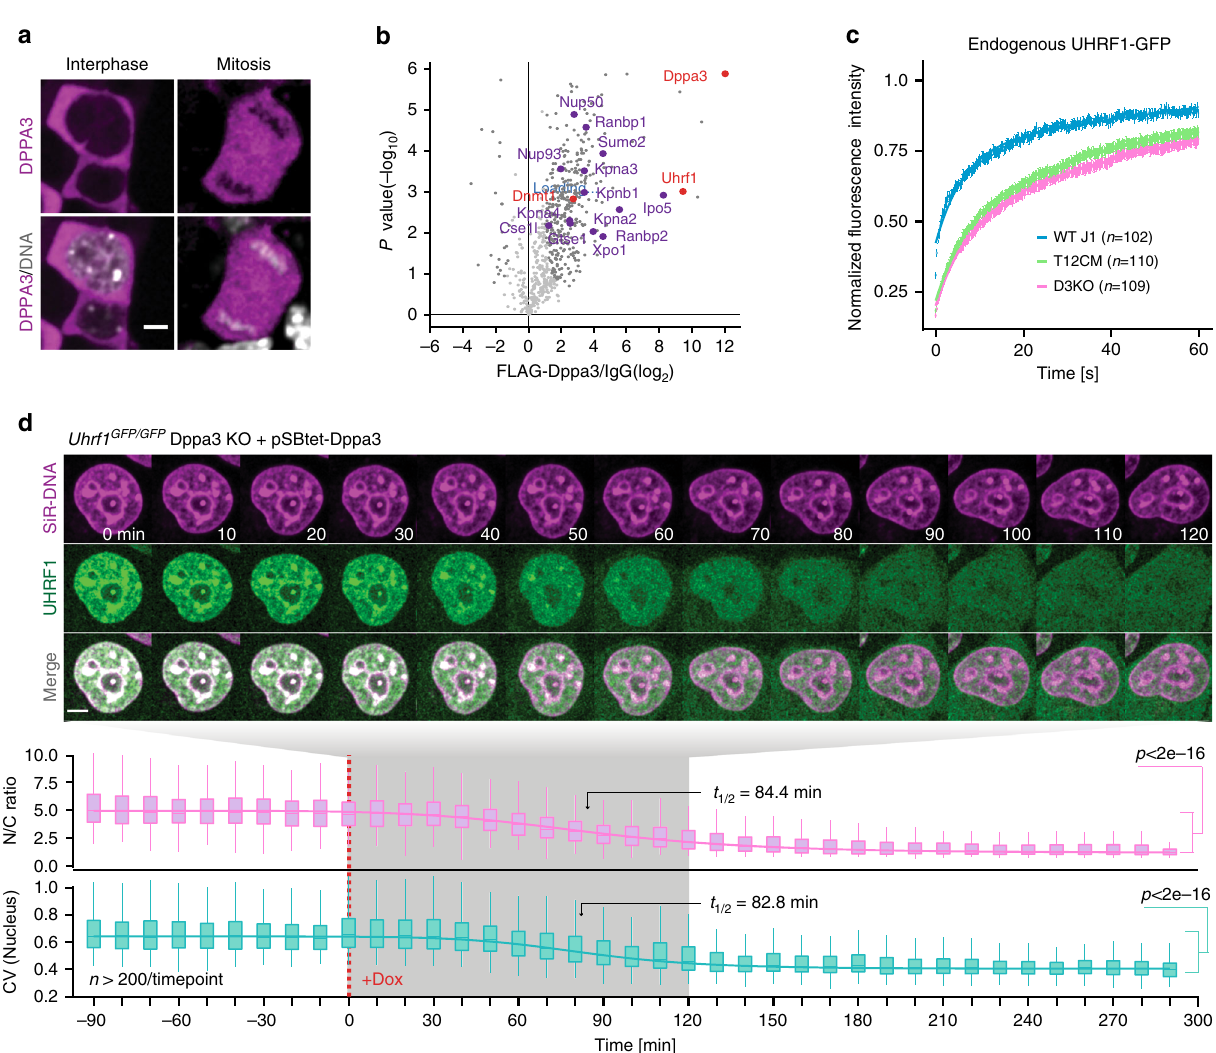
Fig. 4 TET-dependent expression of DPPA3 alters UHRF1 localization and chromatin binding in naïve ESCs. a Localization of endogenous DPPA3-HALO in live ESCs counterstained with SiR-Hoechst (DNA). Representative result, n ≥ 4. Scale bar: 5 μ m. b Volcano plot from DPPA3-FLAG pulldowns in ESCs. Dark gray dots: signi fi cantly enriched proteins. Red dots: proteins involved in DNA methylation regulation. Purple dots: proteins involved in nuclear transport. anti-FLAG antibody: n = 3 biological replicates, IgG control antibody: n = 3 biological replicates. Statistical signi fi cance determined by performing a Student ’ s t test with a permutation-based FDR of 0.05 and an additional constant S0 = 1. c FRAP analysis of endogenous UHRF1-GFP. Each genotype comprises the combined single-cell data from two independent clones acquired in two independent experiments. d Localization dynamics of endogenous UHRF1-GFP in response to Dppa3 induction in U1G/D3KO + pSBtet-D3 ESCs with confocal timelapse imaging over 8 h (10 min intervals). t = 0 corresponds to start of Dppa3 induction with doxycycline ( + Dox). ( top panel ) Representative images of UHRF1-GFP and DNA (SiR-Hoechst stain) throughout confocal timelapse imaging. Scale bar: 5 μ m. (middle panel) Nucleus to cytoplasm ratio (N/C ratio) of endogenous UHRF1-GFP signal. (bottom panel) Coef fi cient of variance (CV) of endogenous UHRF1-GFP intensity in the nucleus. ( middle and bottom panel ) N/C ratio and CV values: measurements in n > 200 single cells per time point (precise values can be found in the Source Data fi le), acquired at n = 16 separate positions. Curves represent fi ts of four parameter logistic (4PL) functions to the N/C ratio (pink line) and CV (green line) data. Live-cell imaging was repeated three times with similar results. In ( c ), the mean fl uorescence intensity of n cells (indicated in the plots) at each timepoint are depicted as shaded dots. Error bars indicate mean ± SEM. Curves (solid lines) indicate double-exponential functions fi tted to the FRAP data. In the boxplots in ( d ), darker horizontal lines within boxes represent median values. The limits of the boxes indicate upper and lower quartiles, and whiskers extend to the most extreme value within 1.5 x the interquartile range from each hinge. P -values based on Welch ’ s two-sided t test. Source data are provided as a Source Data fi